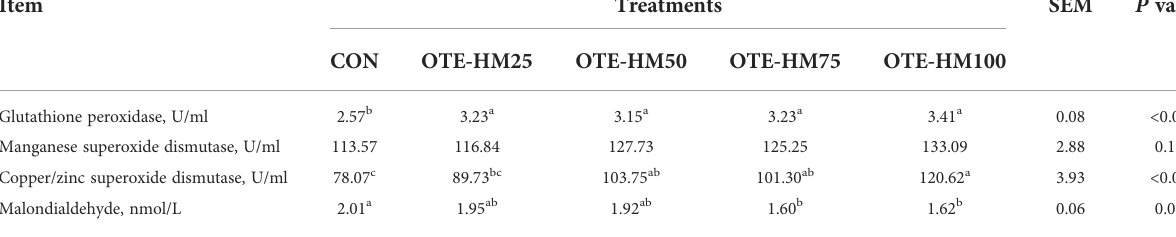
TABLE 5 Effects of experimental diets on antioxidative cytokine levels in serum of laying ducks 1 .